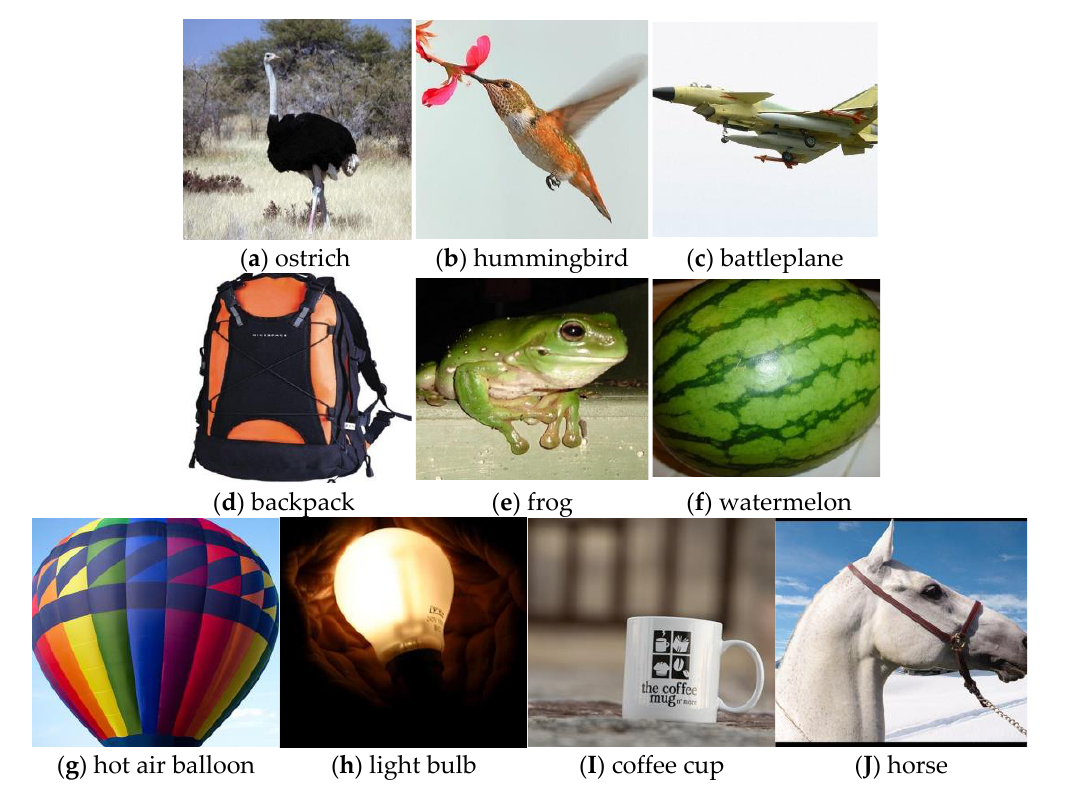
Figure 7. The stimulus images of ten categories from public dataset ImageNet. Table 1. The number of images in each category. Table 2. The training parameters of the proposed algorithm.